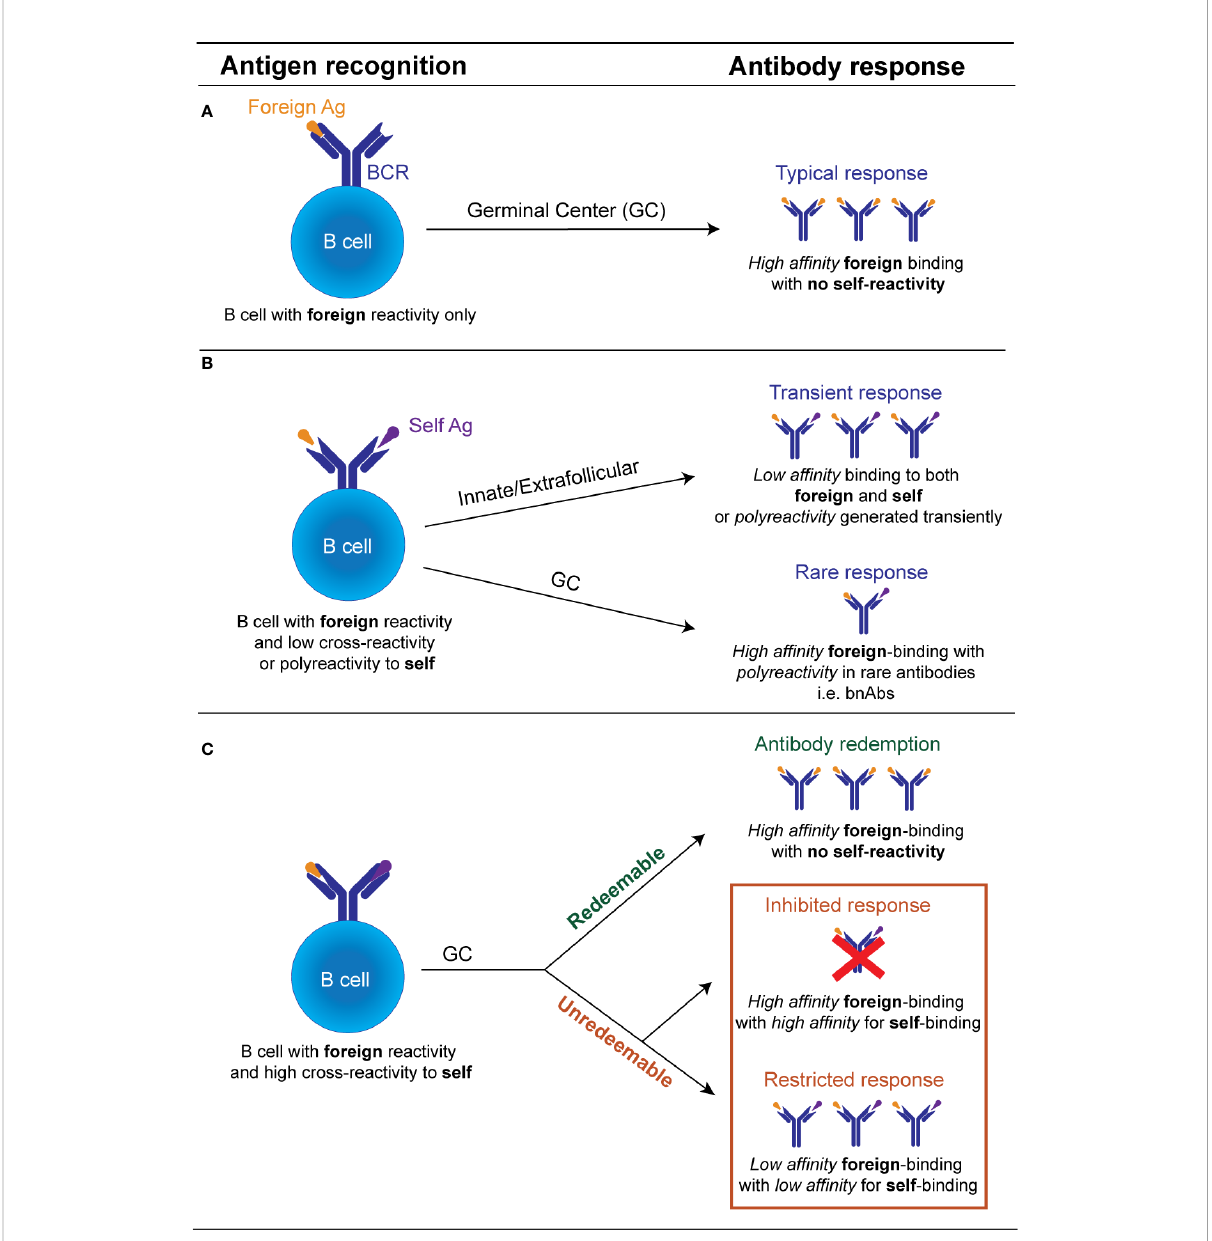
FIGURE 1 Schematic illustration of the possible fates of an individual antibody receptor encountering self versus foreign antigen. (A) . If a B cell possesses an antibody receptor which binds strongly to the foreign antigen, but exhibits minimal binding of the self-antigen and minimal polyreactivity, there is no restriction of entry into the GC. Within the GC, B cells undergo af fi nity maturation of its BCR and af fi nity-based selection. If this B cell acquires mutations that increase self-reactivity de novo it undergoes negative selection by self-tolerance mechanisms. GC B cell with improved anti-foreign binding without detectable increased self-reactivity undergo positive selection to produce high af fi nity anti-foreign antibodies. (B) . If a B cell binds to a foreign antigen but possesses low cross-reactivity or polyreactivity to self-antigens it may still be recruited transiently into the early extrafollicular plasmablast response without entering the GC, releasing unmutated germline polyreactive antibodies. De novo generated GC B cells bearing low self-reactivity or polyreactivity may also leave the GC as terminally differentiated antibody-producing plasma cells, likely in situations where the foreign antigen binding is inherently linked to their polyreactivity properties e.g. broadly neutralizing antibodies. (C) . B cell with high cross-reactivity to both self and foreign antigens can enter the GC response but largely by-passes recruitment into the early extrafollicular response. Within the GC, this B cell acquires mutations that reduce its autoreactivity. If mutational trajectories are found which decrease self-binding while concurrently maintaining or enhancing foreign binding, these will undergo positive selection and eventually outcompete mutational trajectories which concurrently decrease self and foreign binding. If no mutational trajectories are possible which reduce autoreactivity while concurrently maintaining foreign binding, B cells with high self-binding will be deleted or outcompeted. Only B cells with diminished binding to both the self and the foreign antigen will be positively selected. The processes that facilitate the selection of GC B cells with reduced foreign and self-binding, are currently unde fi